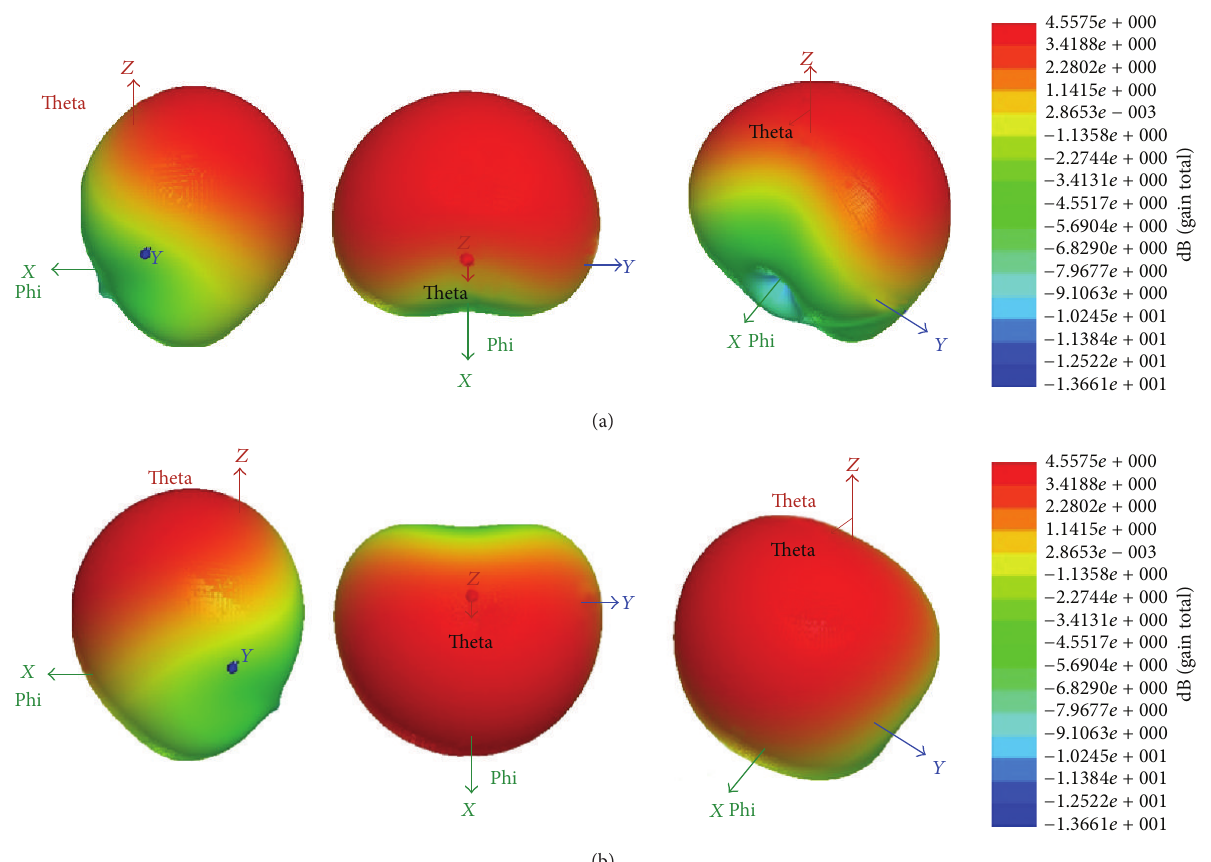
Figure 10: 3D radiation pattern for the both cases as mentioned in Table 1, with 𝑎 = 32 mm, 𝑏 = 29.6 mm, 𝑑 = 48.85 mm, 𝐿 1 = 30 mm, = 5.3 mm, 𝐿 = 22 mm, 𝑊 = 1.5 mm, and 𝑀 = 20 mm and 𝑀 = 45 mm, 𝑇 = 2.95 mm, 𝑑 𝑊 1 2 2 1 2 and 𝐿 = 𝑊 = 130 mm. (a) Case I (1.6GHz) and (b) Case II (1.6GHz).